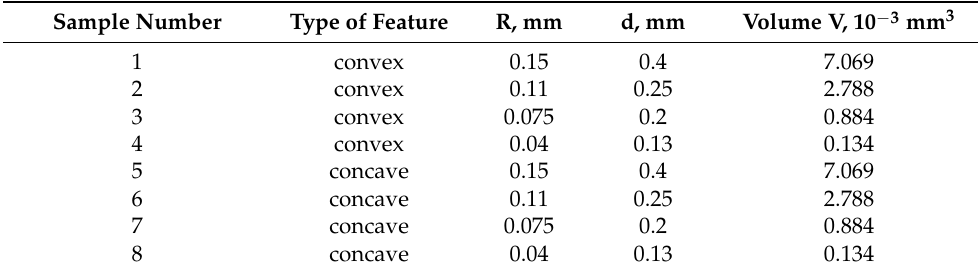
Table 3. Summary of morphological